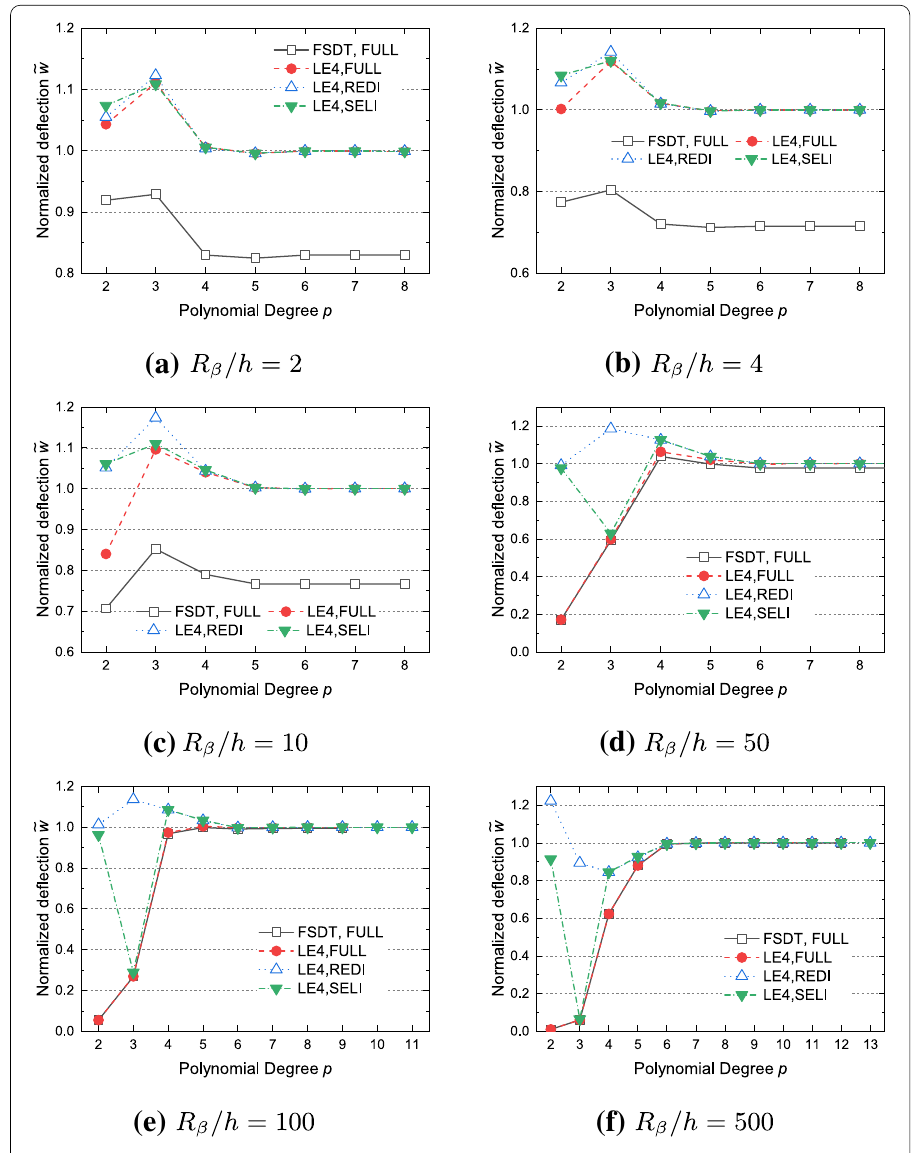
Fig. 8 Convergence regarding the normalized deflection of FE models for the three-layered cylindrical shells under distributed pressure, for various radius-to-thickness ratio R β / h